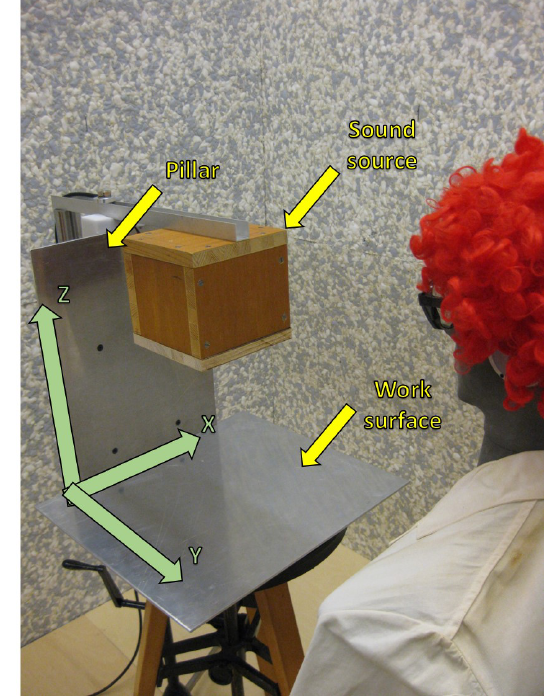
Figure 4. Experimental setup used for the simulation of an idealized sound field produced by an ultrasonic welding machine. The setup was built within the free-field environment at PTB in Braunschweig,